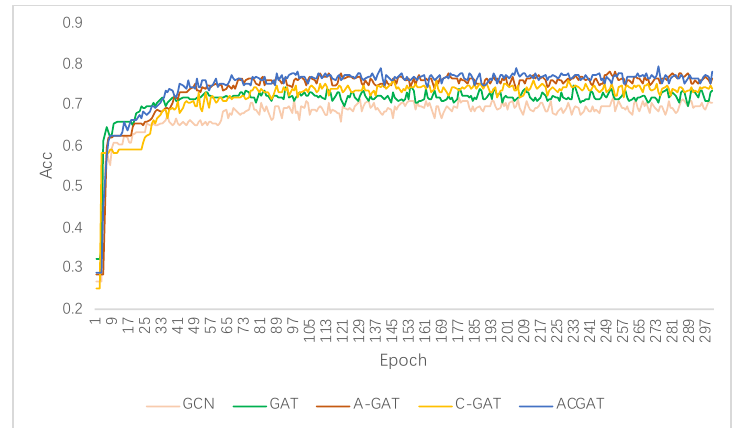
Figure 14. Comparison results of neural network models on the Citeseer citation